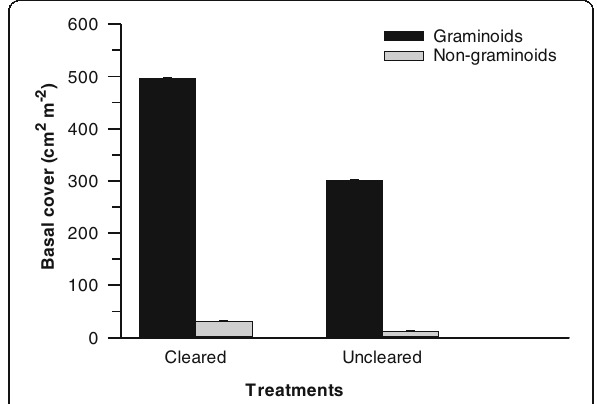
Fig. 2 The mean basal cover of graminoid and non-graminoid plants in cleared and uncleared sites. Bars indicate the mean values, and the whiskers indicate the standard